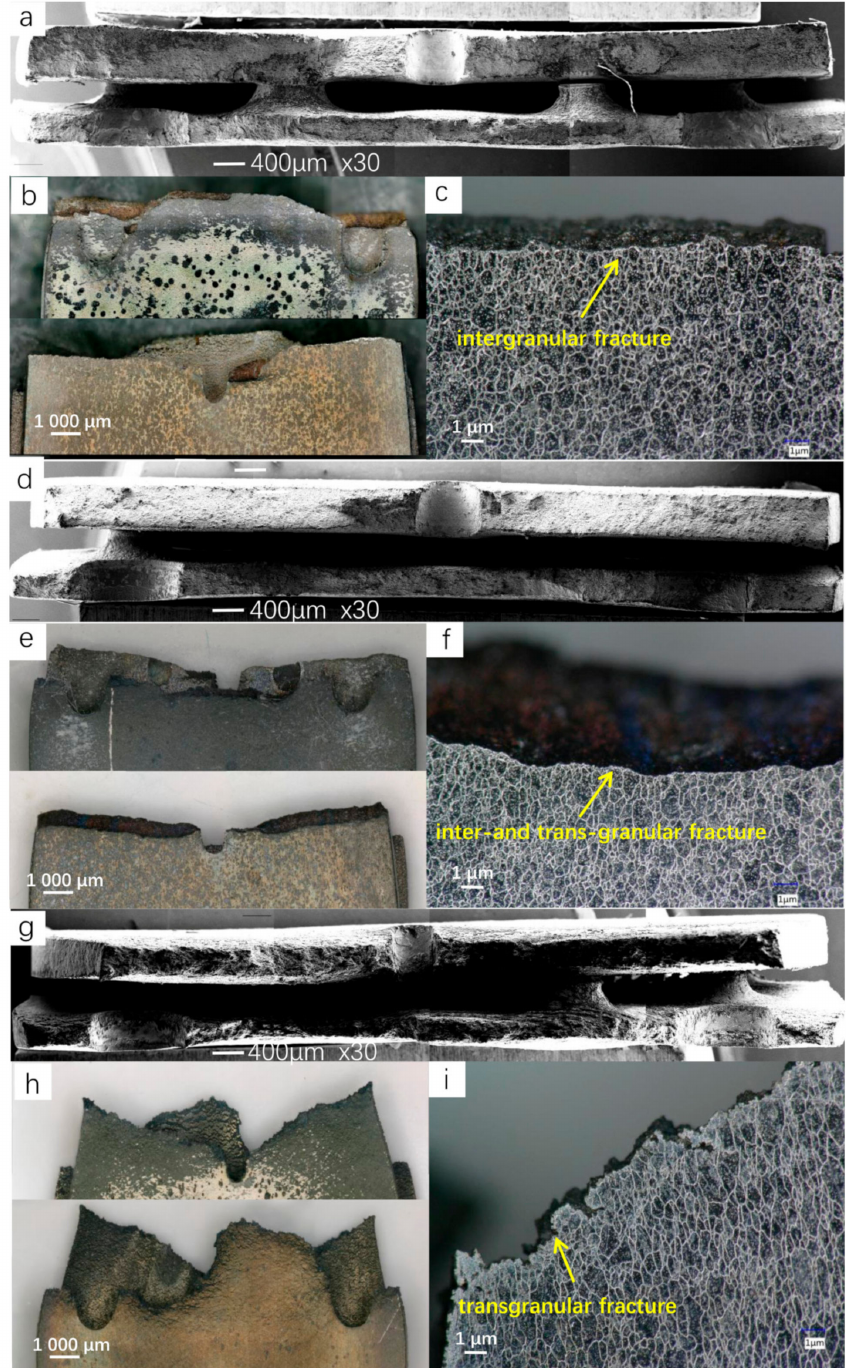
Figure 7. Fracture morphology and side morphology after electrochemical corrosion. ( a – c ) 650 ◦ C; ( d – f ) 750 ◦ C and ( g – i ) 850 ◦